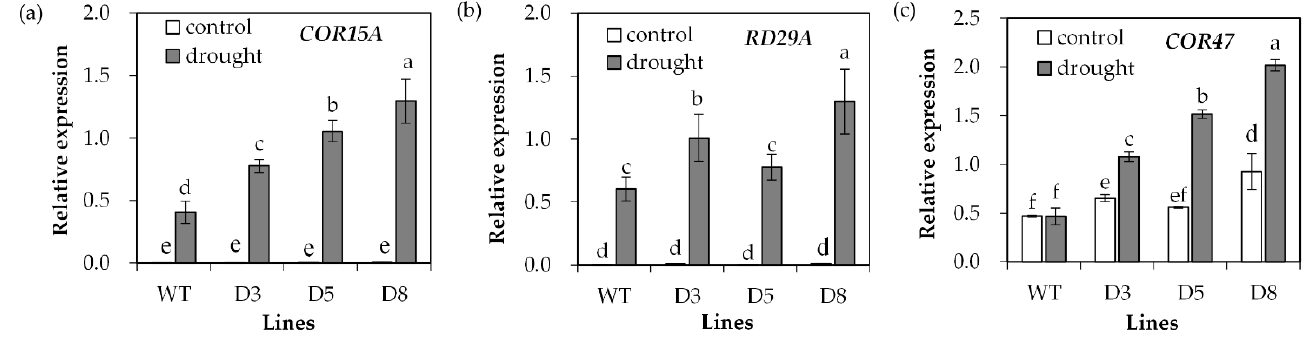
Figure 8. Analysis of drought-responsive marker gene expression in response to drought. Two-week-old seedlings were withheld from irrigation for 14 days (drought) or continuously irrigated as control, and leaves were sampled for determination of the relative expression of drought-responsive genes including COR15A ( a ), RD29A ( b ) and COR47 ( c ). Means of three replicates and standard errors are presented; the same letter above the column indicates no significant difference at p < 0.05.